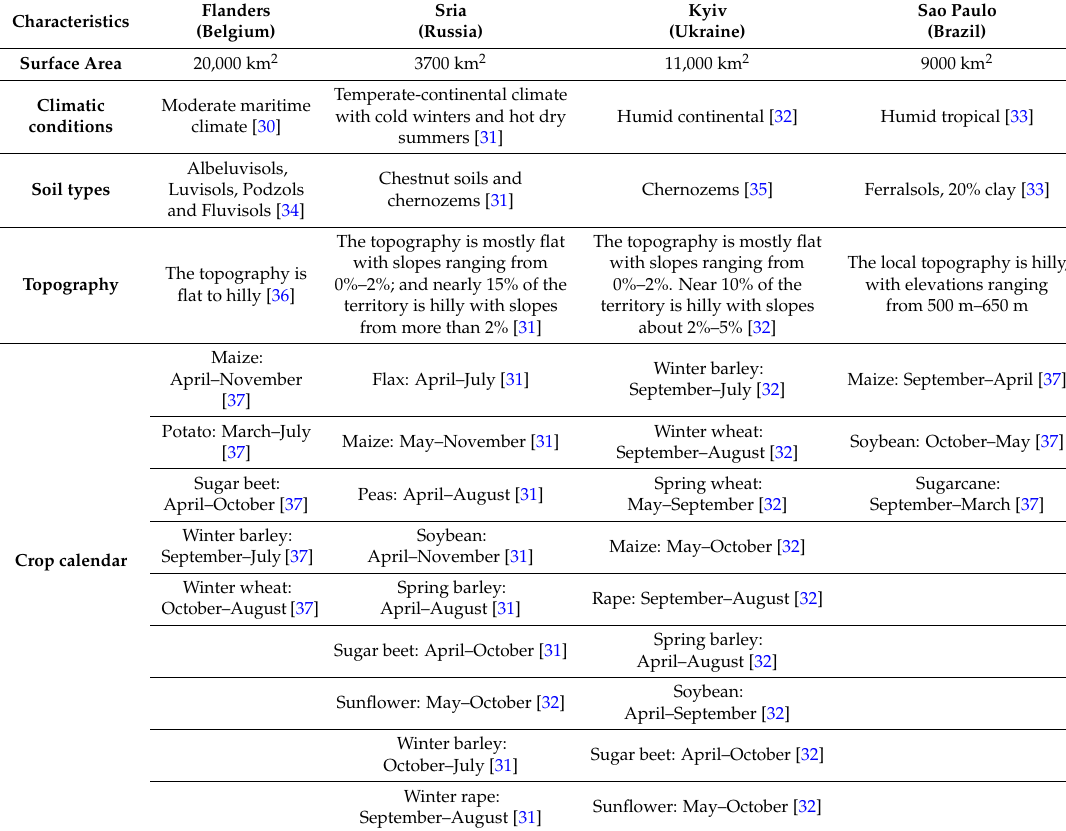
Table 1. Site characteristics.